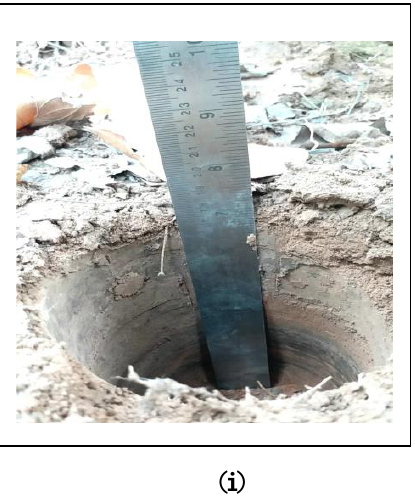
Figure 2. ( a ) Distant view of land degradation caused by opencast mining. ( b ) Distant view of reclaimed dump. ( c ) Reclaimed overburden (OB) dump after 5 years of plantation. ( d ) Reclaimed OB dump after 10 years of plantation. ( e , f ) Reclaimed OB dump after 25 years of plantation. ( g , h ) Natural forest site (reference site). ( i ) Profile (0–20 cm) sampling of reclaimed mine soil.